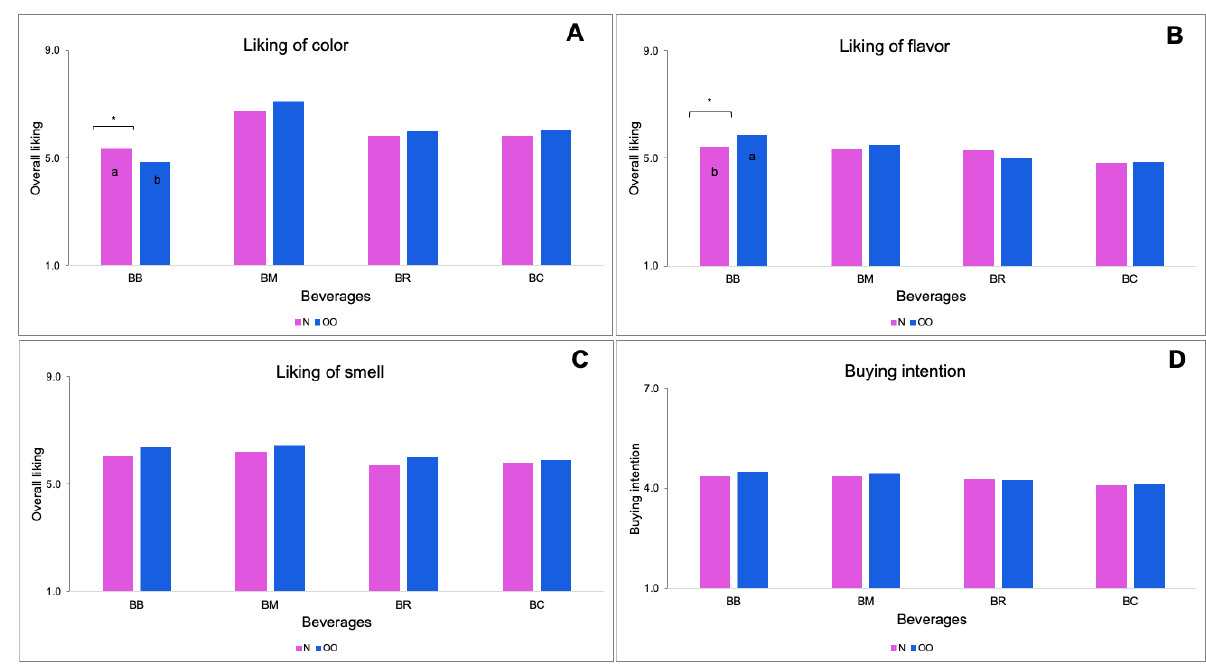
Figure 3. Mean (n = 400) of scores for liking (( A ): color, ( B ): flavor, ( C ): smell) and buying intention ( D ) of the developed beverages according to the weight condition (normal weight -N- and overweight and obesity -OO-). Different lowercase letters between bars indicate significant difference ( * p < 0.05).